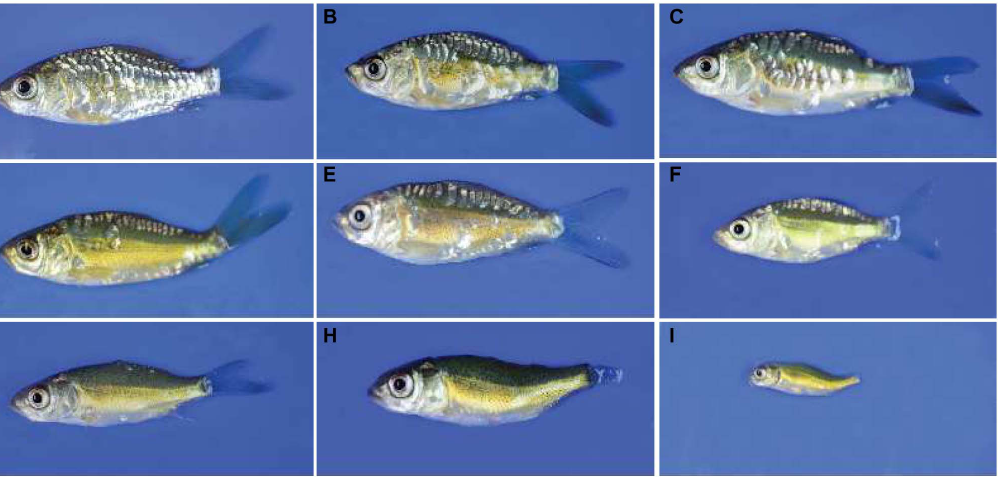
Figure 1. Variations observed in Kirpichnikov’s ‘‘scattered’’ scale pattern and nude phenotypes. The scattered phenotype can be further divided into two sub-types: irregular (panels A–C) and classical mirror (D–F). The nude phenotype can also be divided into three sub-types: nude1 (G), nude2 (H) and nude3 (I). (These three sub-types were not separated during the analysis of phenotypes.).